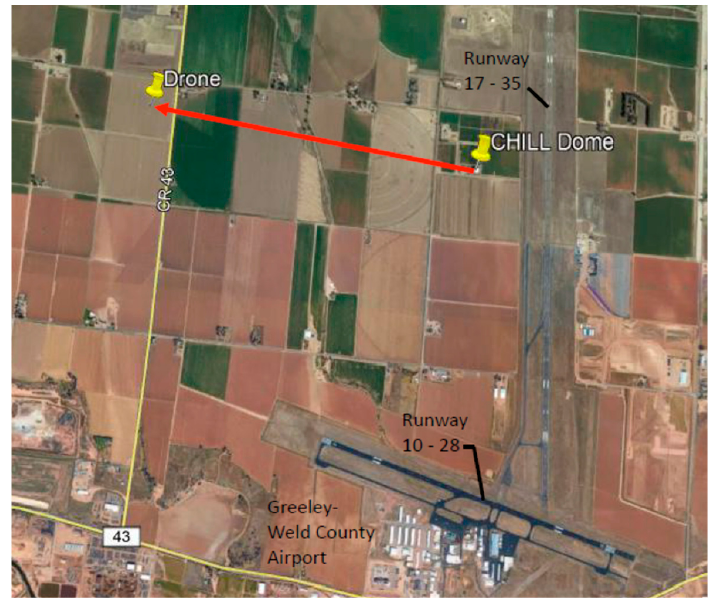
Figure 3. Location of the D3R radar and UAV projected on Google Earth